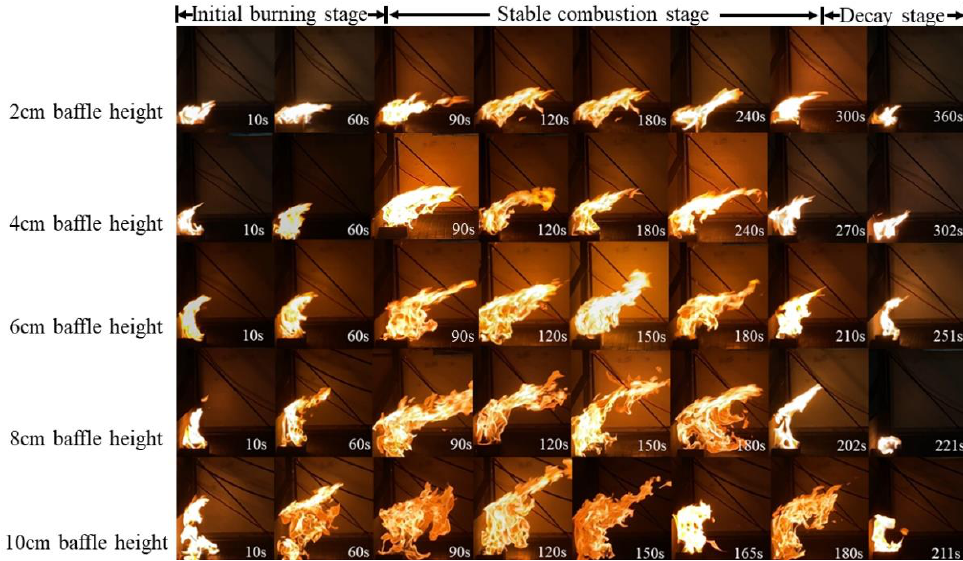
Figure 2. Changes in pool fire flame shape with time at a 3 m/s crosswind and different baffle heights.